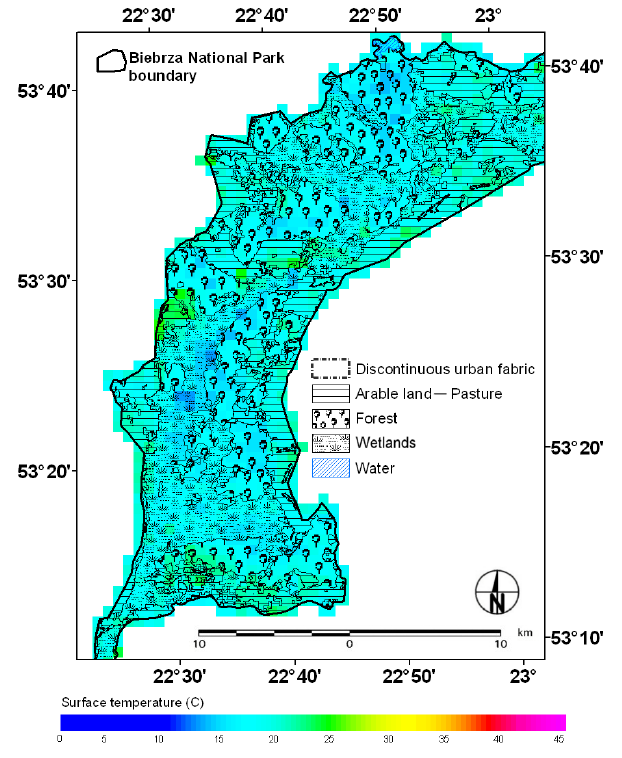
Figure 14. Surface temperatures at the test site at the turn of April/May 2008 (wet season).